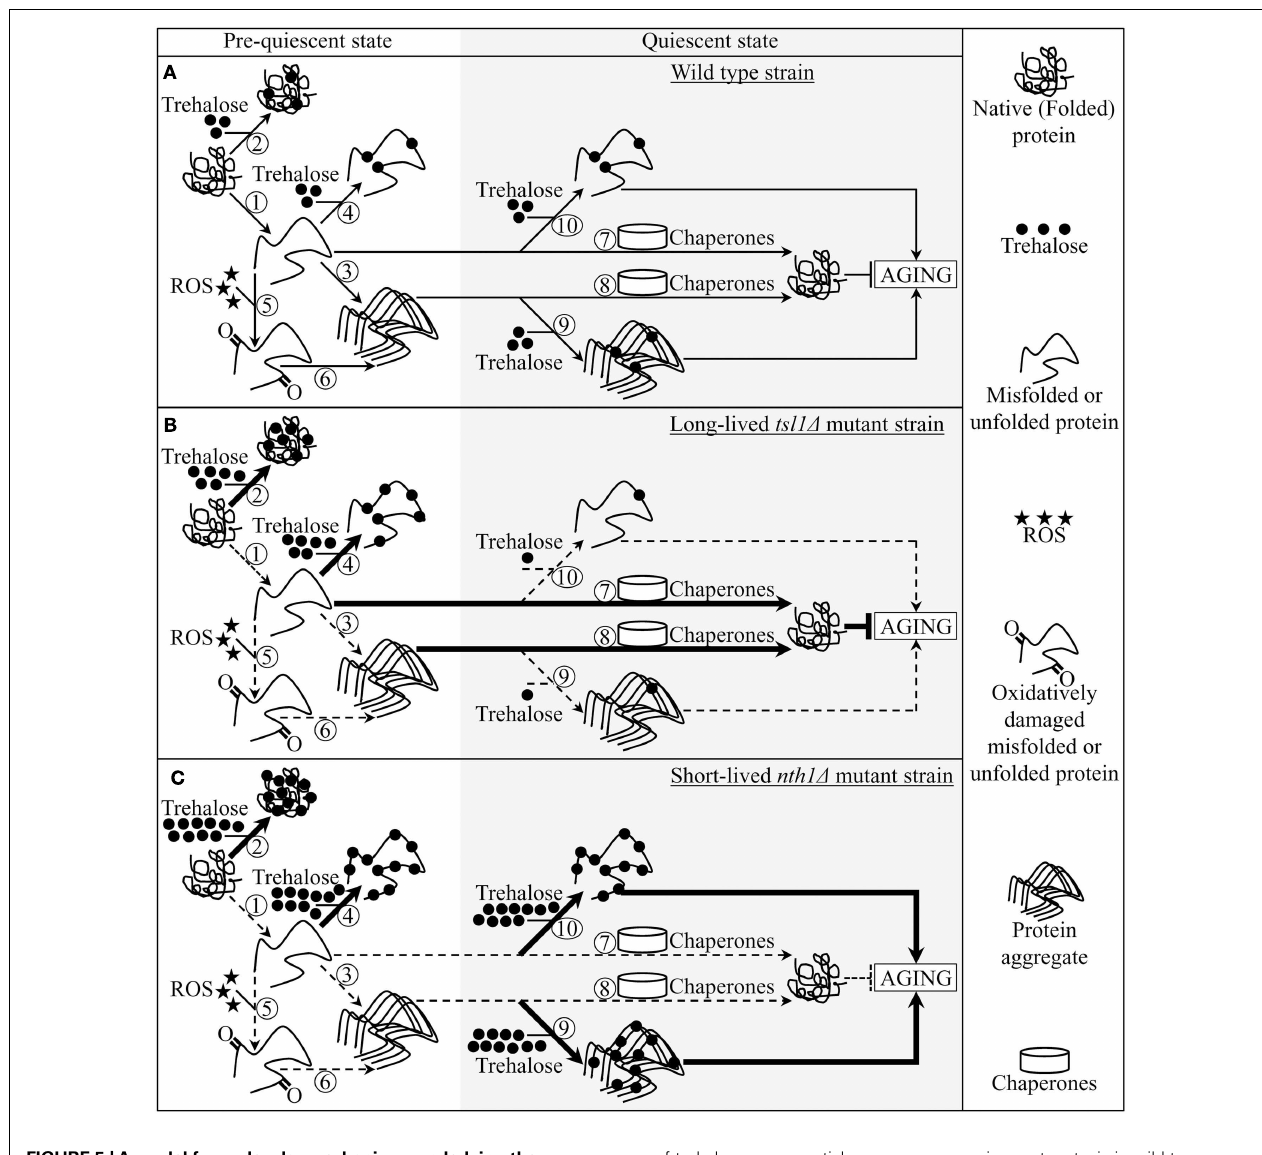
FIGURE 5 |A model for molecular mechanisms underlying the essential role of trehalose in defining yeast longevity by modulating cellular proteostasis throughout lifespan. The outlined model adequately explains how the tsl1 ∆ and nth1 ∆ mutations altering a pattern of age-related changes in trehalose concentration influence a longevity-defining balance between protein folding, misfolding, unfolding, refolding, oxidative damage, solubility, and aggregation. (A–C) The effects